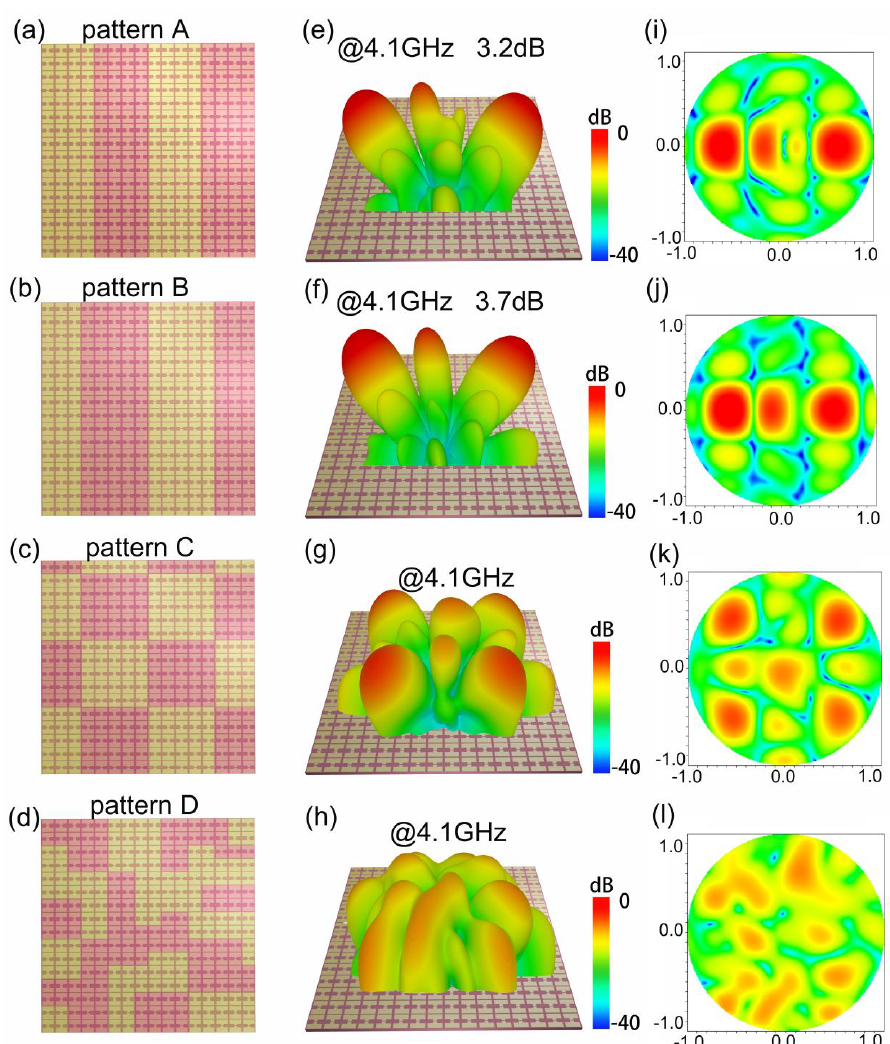
Figure 4. Four coding patterns of the metasurface and their corresponding far-field results. ( a ) Pat- tern A coding as “0000111100001111”. ( b ) Pattern B coding as “0000111100001111”. ( c ) Pattern C horizontal coding as “00011110000111”. ( d ) Pattern D is randomly coding. ( e – h ) Far-field simulation results of patterns A – D at 4.1 GHz. ( i – l ) Two-dimensional displays of far-field results of patterns A – D at 4.1 GHz.